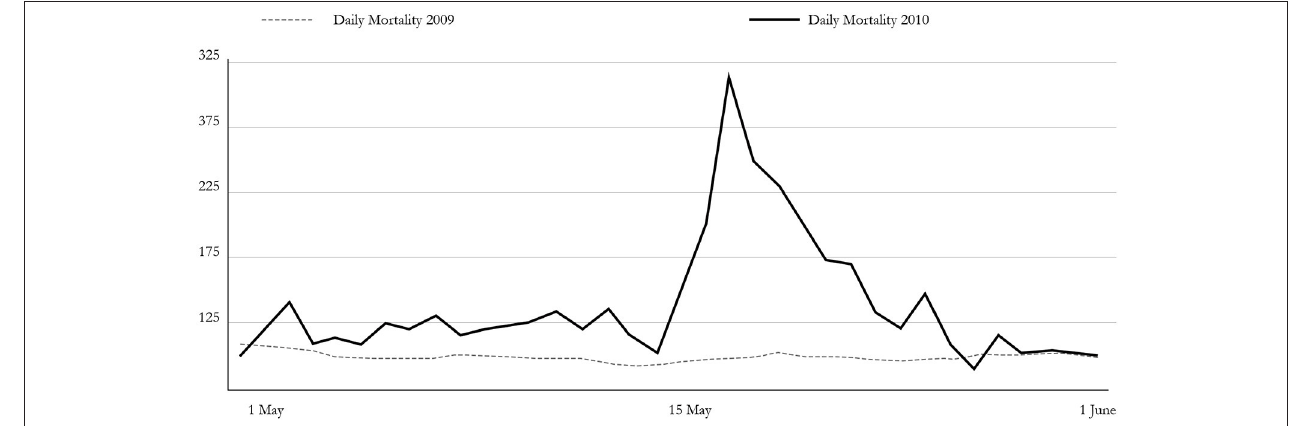
FIGURE 1 | Ahmedabad mortality rate during heat wave 2010 compared to previous year. Reproduced from Azhar et al.